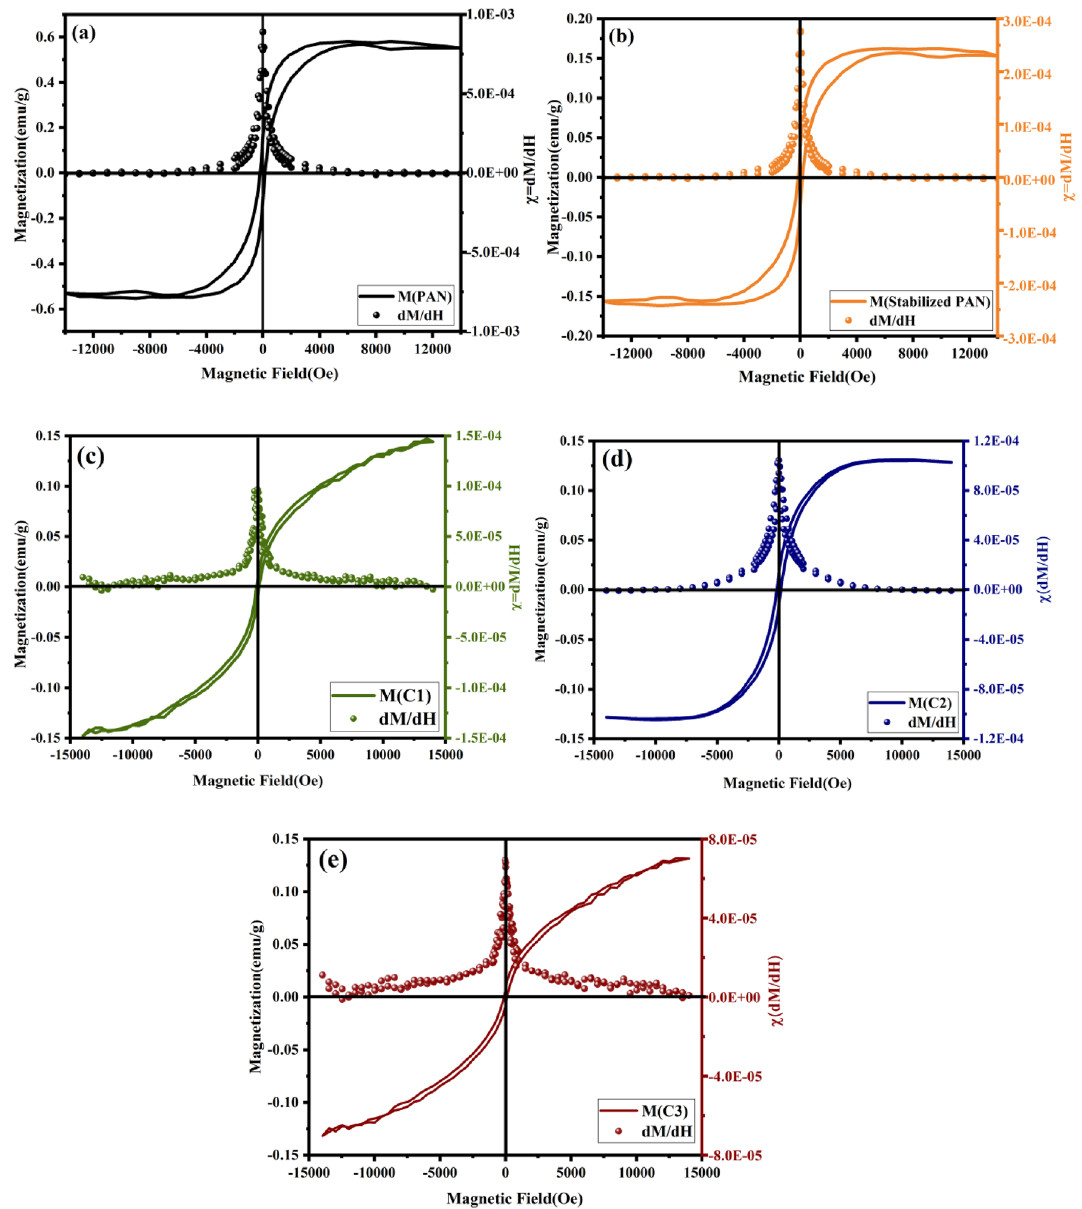
Figure 12. Magnetization vs. magnetic field curve, and the first derivative of M with respect to H for ( a ) PAN, ( b ) stabilized, ( c ) C1, ( d ) C2, ( e ) and C3 fibers.